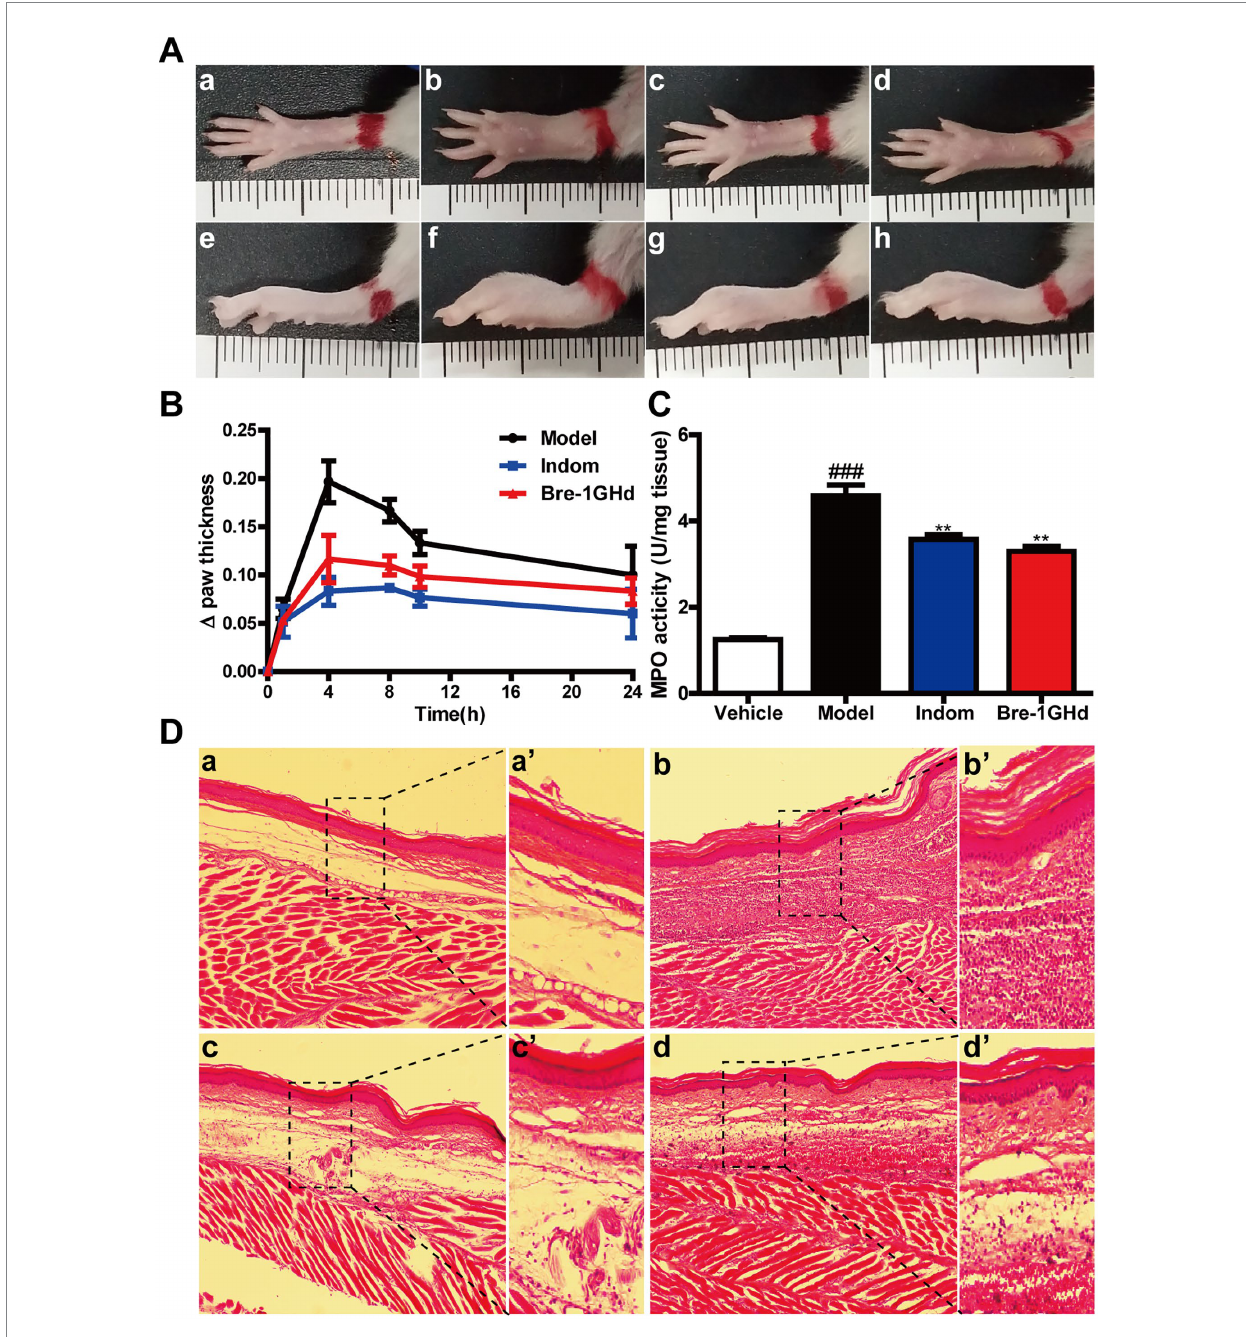
FIGURE 5 Treatment of carrageenan-induced acute inflammation in mice paw by Brevinin-1GHd. (A) Mice paws at 4 h after carrageenan administration. Panels a–d and e–h indicate the corresponding bottom and lateral views of the paws. Images from left to right are the control group (a,e) , the model group (b,f) , Indomethacin group (c,g) and Brevinin-1GHd group (d,h) . (B) Thickness of right paw of mice at different time points within 24 h. (C) MPO activity in the right paw of mice at 4 h after administration. (D) HE staining of the right paw of mice at 4 h after administration. Labels (a,a’) – (d,d’) refer to